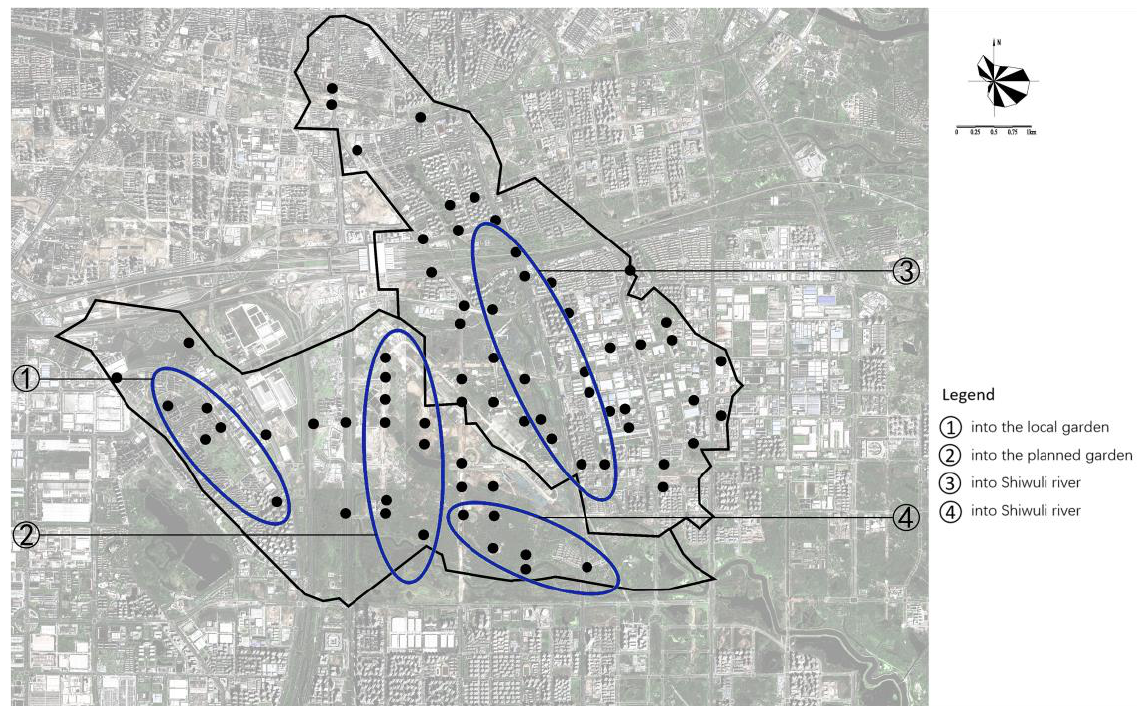
Figure 6. The region of blue-green transformation planning in the middle stream.